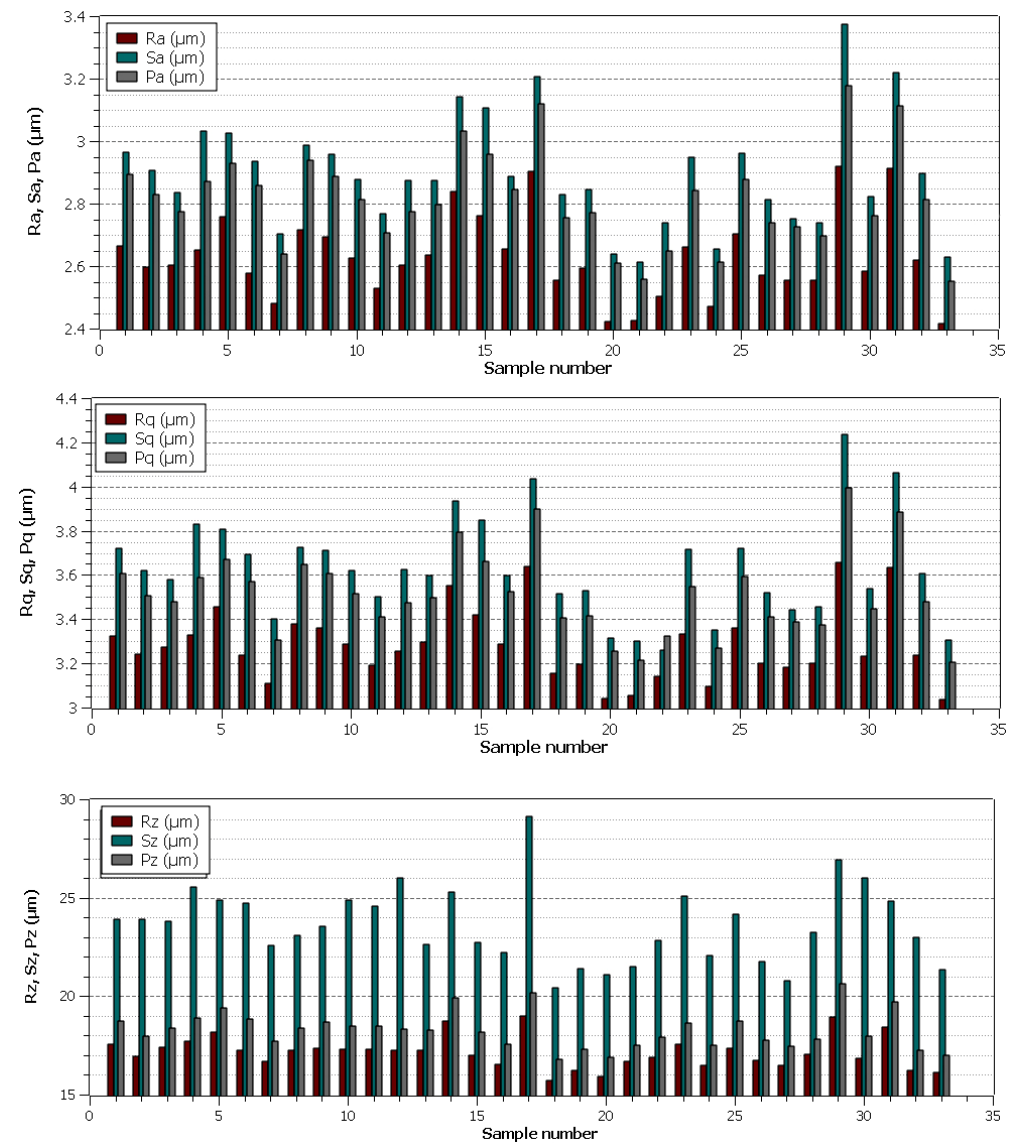
Figure 2. The evaluated basic profile parameters, profile and area parameters of individual experimental samples.